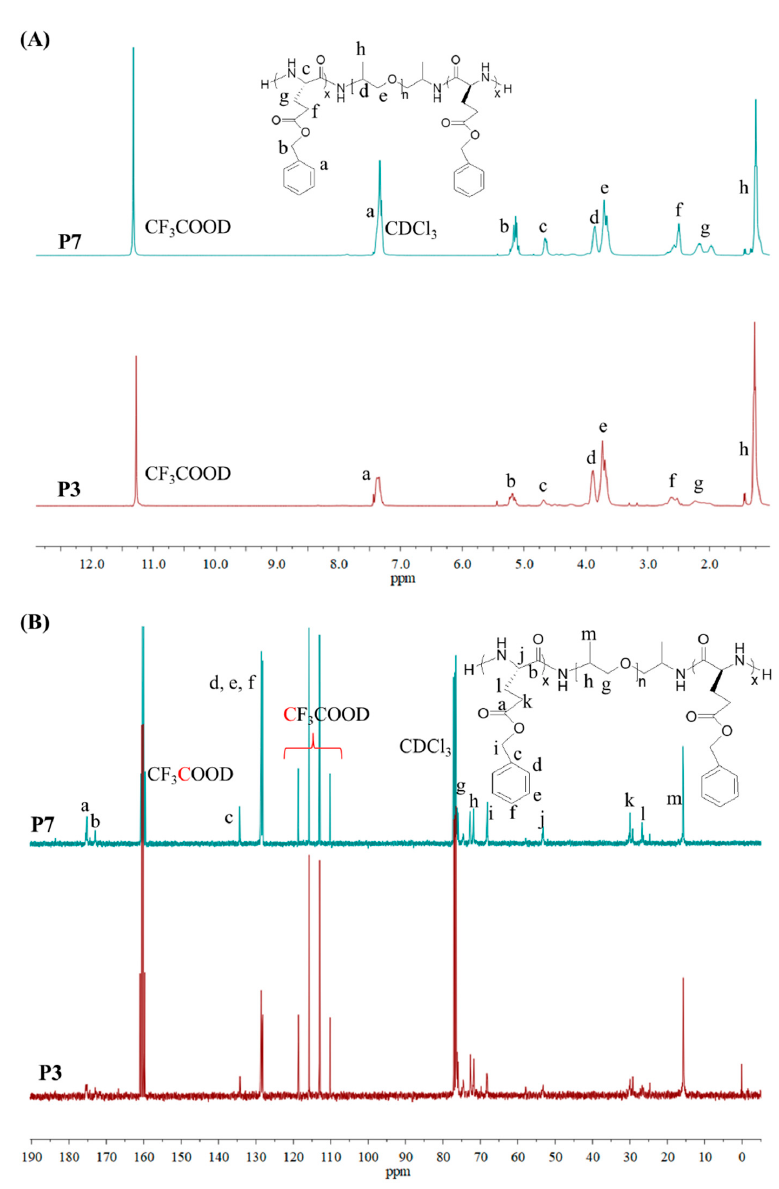
Figure 1. 1 H ( A ) and 13 C ( B ) NMR spectra of PBLG- b -PPG- b- PBLG ( P3 and P7 ).